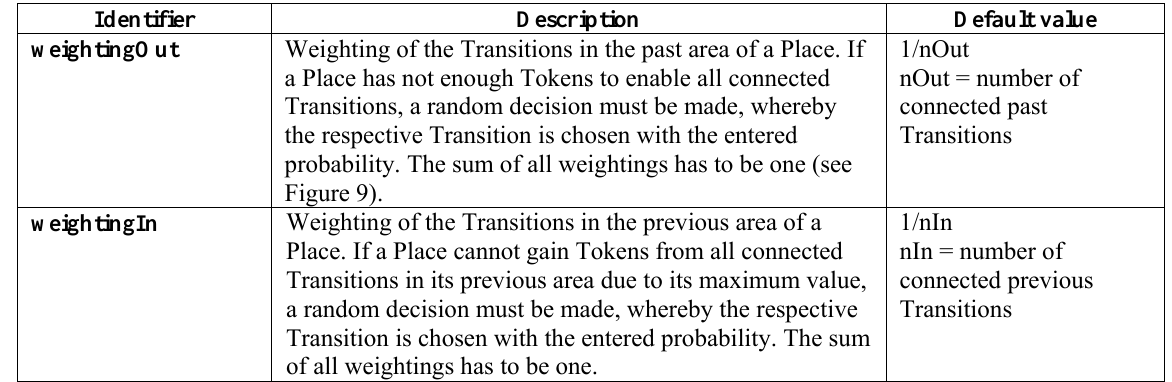
Table 2: Parameters only of a discrete